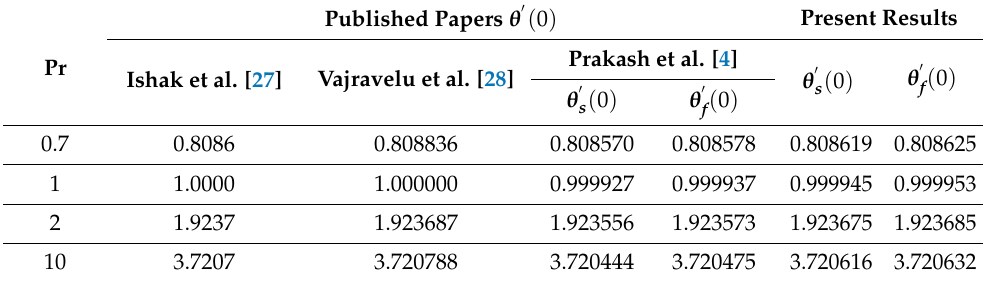
Table 1. Comparison of results for the thermal gradient with published papers for some re- duced